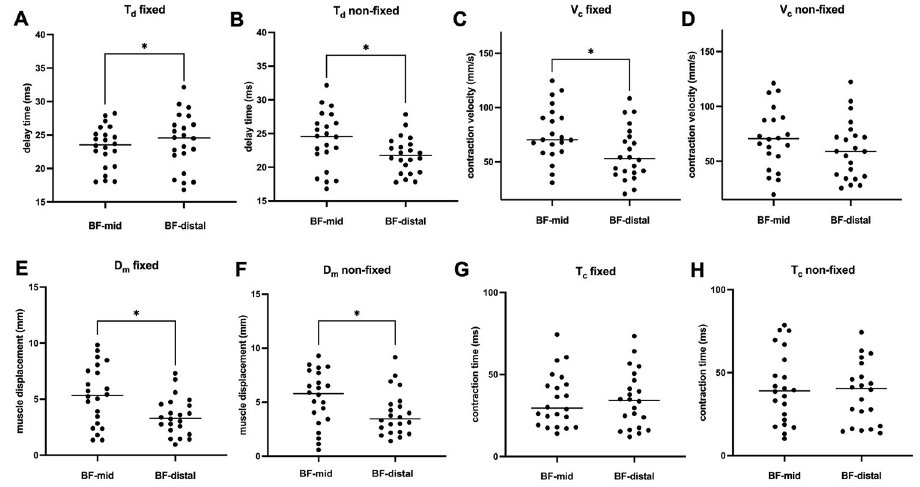
Fig 3. Differences between the TMG-derived parameters for measurement sites on the m. biceps femoris. A = differences in T d for the fixed condition; B = differences for T d in the non-fixed condition; C = differences in V c in the fixed condition; D = differences in D m in the fixed condition; E = differences in D m in the non-fixed condition. [ � ] = significant difference between the measurement sites. mm vs. 3.5 ± 1.7 mm; non-fixed: 5.4 ± 2.5 mm vs. 4.0 ± 2.0 mm). For T , no significant differ- c ences between the measurement sites were found (fixed, p = 1.0; non-fixed, p = 1.0). V only c revealed significant differences between the measurement sites in the fixed condition with a mean difference of -19.5 mm/s (95% CI: -44.8 and -2.5 mm/s, p = 0.02, d = 0.7). Likewise, V c z revealed larger values at BF-mid (V : 76.7 ± 25.1 mm/s vs. 57.2 ± 24.3 mm/s). c